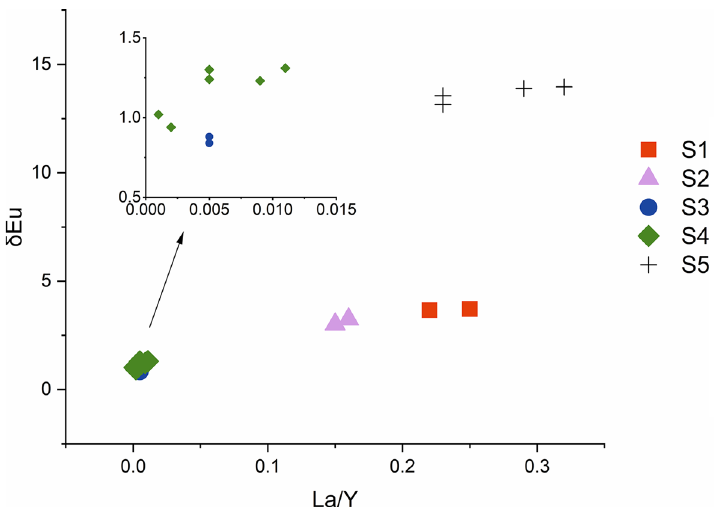
Figure 10. La/Y vs δEu for the QGC.